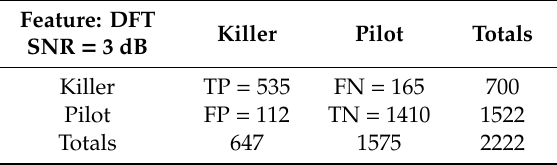
Table 7. Classification results: DFT, SNR = 3 dB.